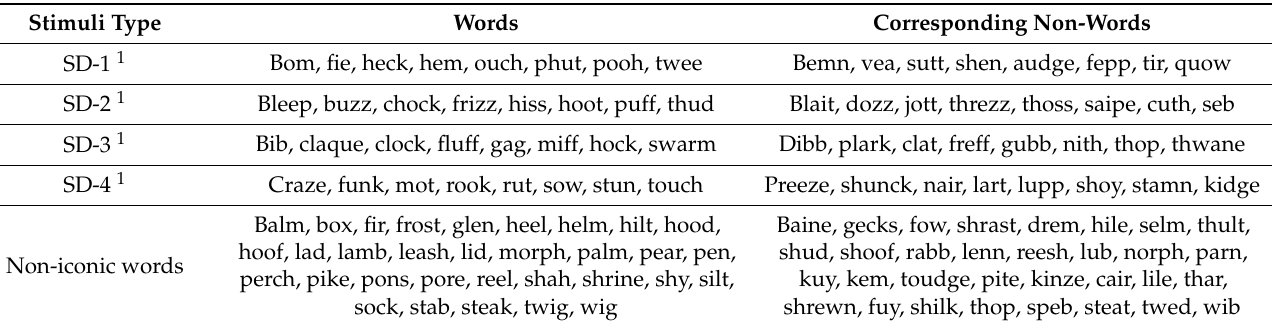
Table 2. Experimental